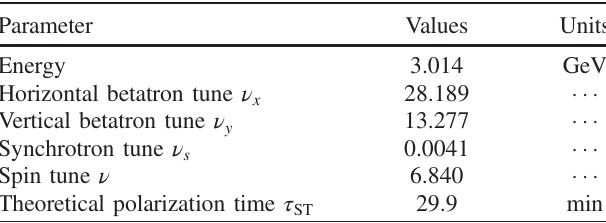
TABLE I. The diamond storage ring parameters.